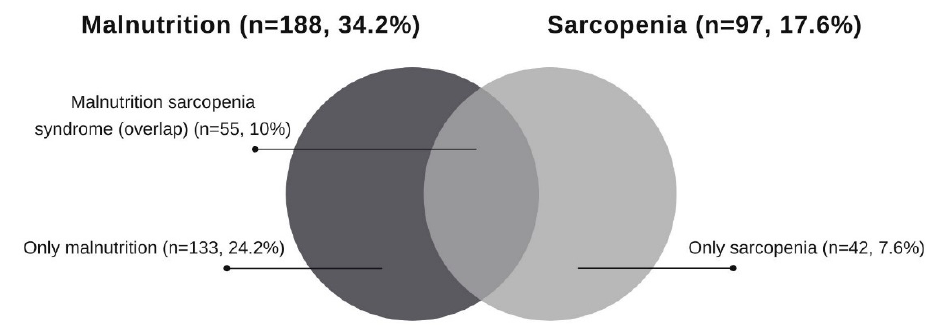
Figure 1. Overlap between malnutrition and sarcopenia in hospitalized patients ( n = 550).